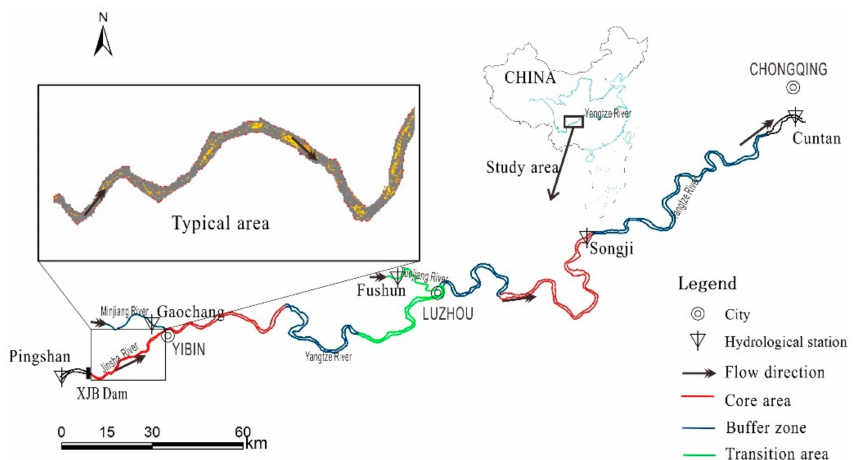
Figure 1. Study area of the upper Yangtze reach from the Xiangjiaba Dam (XJB) to the upper end of the Three Gorges Reservoir (Chongqing), covering approximately 392 km of the river length. The two small red triangles indicate the start and end of the study area. The core area of the reach is displayed in red, the buffer zone in blue, and transition area in green. The expanded part shows the area chosen for weighted usable area (WUA) calculation.